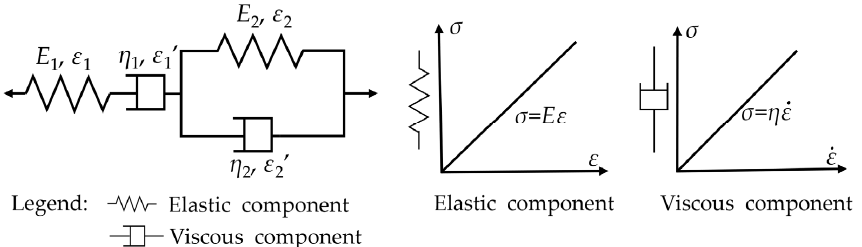
Figure 6. The Burgers creep model : a combination of elastic components and viscous components.